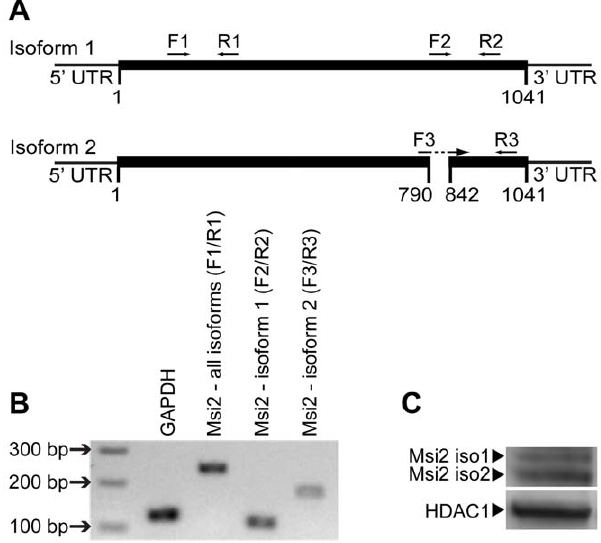
Figure 1. Expression of Msi2 mRNA and protein in ESC. ( A ) Primers for RT-qPCR were designed to be specific for both isoforms of Msi2, isoform 1 or isoform 2. Primer set F1/R1 amplifies sequences present in both isoform 1 and 2. Primer sets F2/R2 and F3/R3 are specific to isoform 1 and isoform 2, respectively. ( B ) DNA fragments generated via RT-qPCR using RNA isolated from D3 ESC and the primer sets indicated were separated over a 2% agarose gel. ( C ) Western blot analysis of Msi2 isoforms expressed in nuclear extracts isolated from D3 ESC. Isoform 2 runs slightly faster than isoform 1 (35.7 kDa and 36.9 kDa, respectively) [5]. HDAC1 protein was used as a loading control.